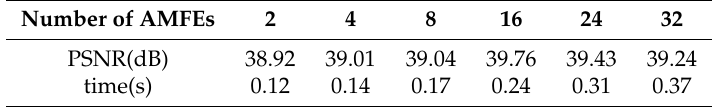
Figure 6. Loss values of different numbers of AMFE with scale factor ×2. Table 2. PSNR and cost time of different numbers of AMFE with scale factor ×2.